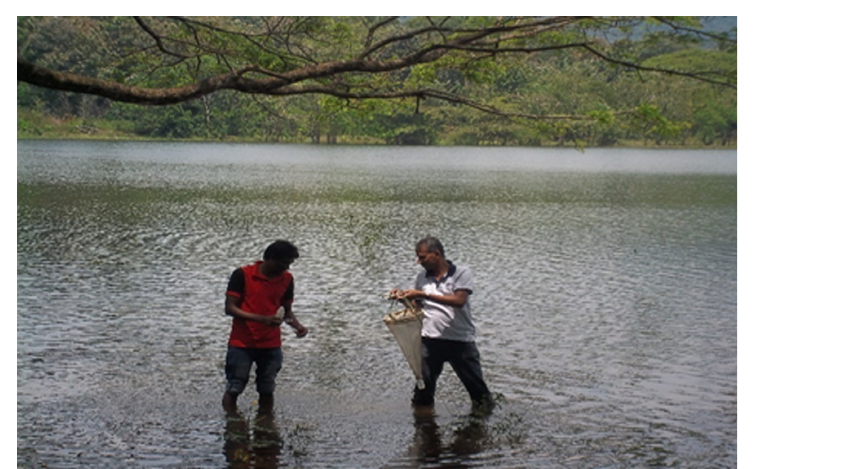
Fig 1. Collection of copepods from water